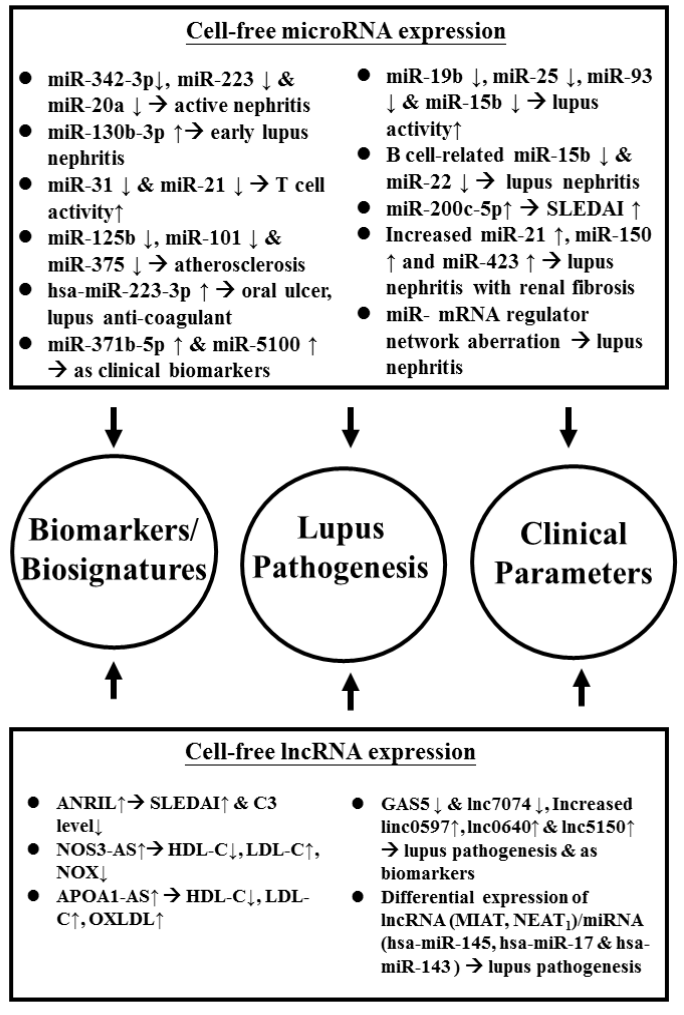
Figure 2. Aberrant cell-free ncRNA expression implicated in the pathogenesis, disease biomarkers/biosignatures, and different clinical parameters in patients with SLE. APOA1: apoprotein